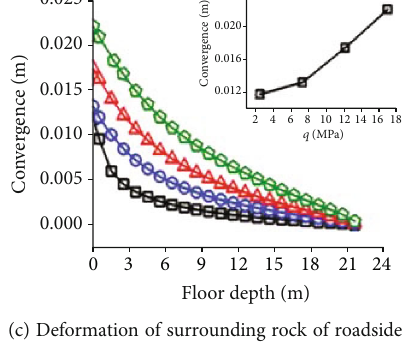
Figure 6: The convergence of surrounding rocks under various deviatoric